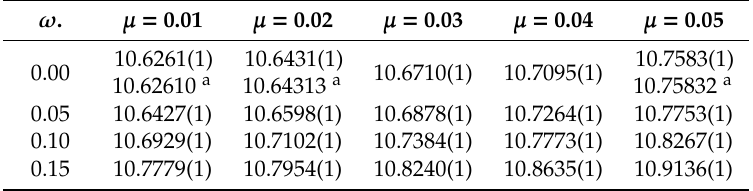
Table 3. The dynamic octupole polarizability (in a.u.) of the screened-He for di ff erent screening parameters and frequency. The numbers in the parentheses denote the uncertainty in the last quoted digits. a Ref.